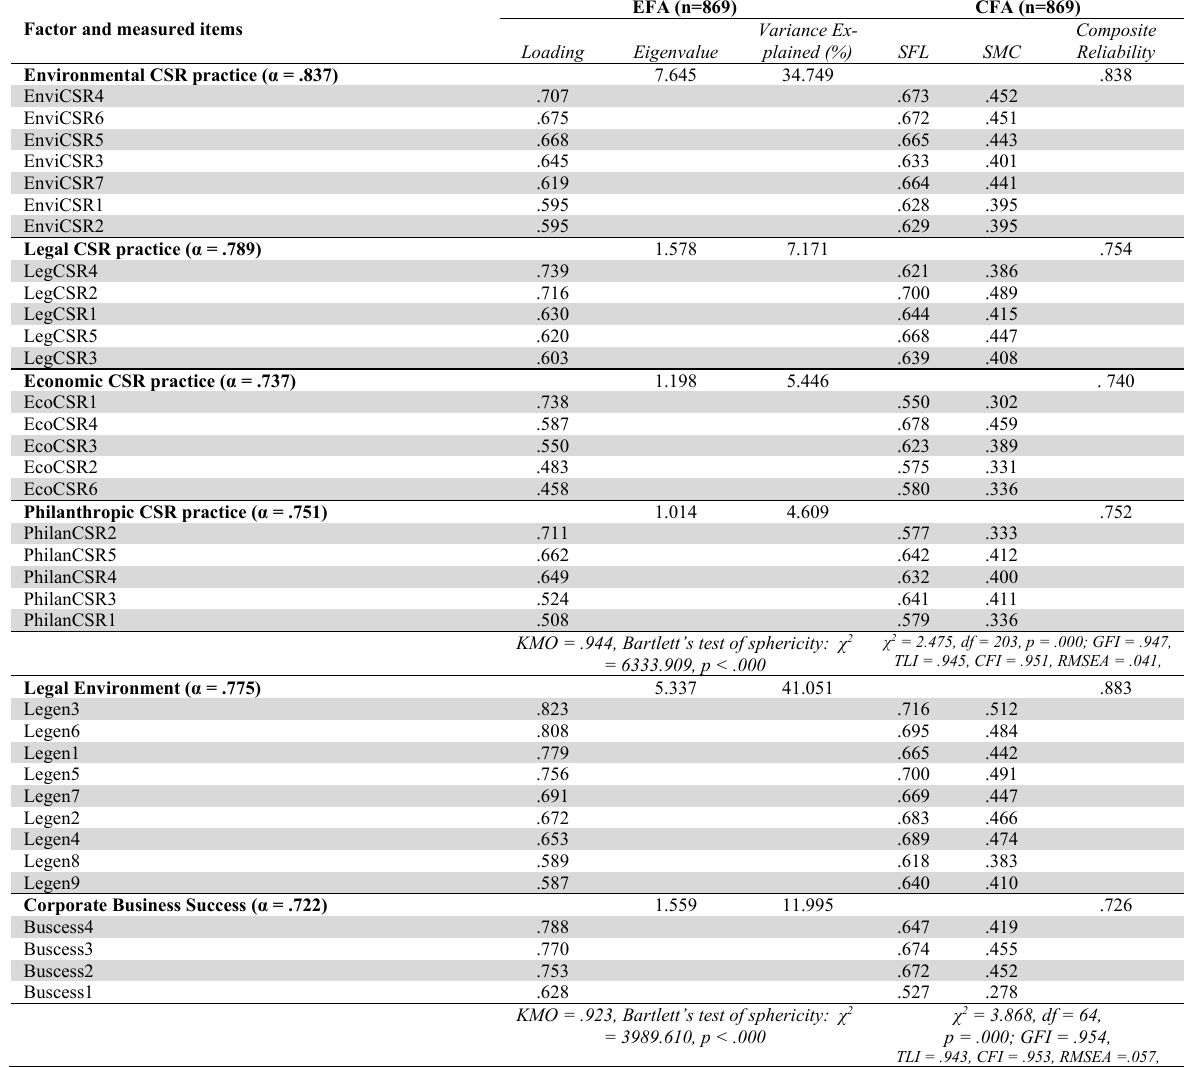
EFA (n=869) CFA (n=869) Variance Ex- Loading Eigenvalue plained (%) SFL SMC